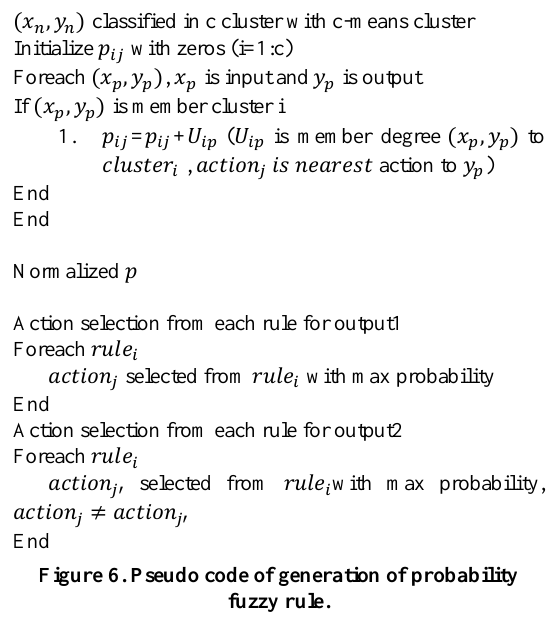
Figure 6. Pseudo code of generation of probability fuzzy rule.